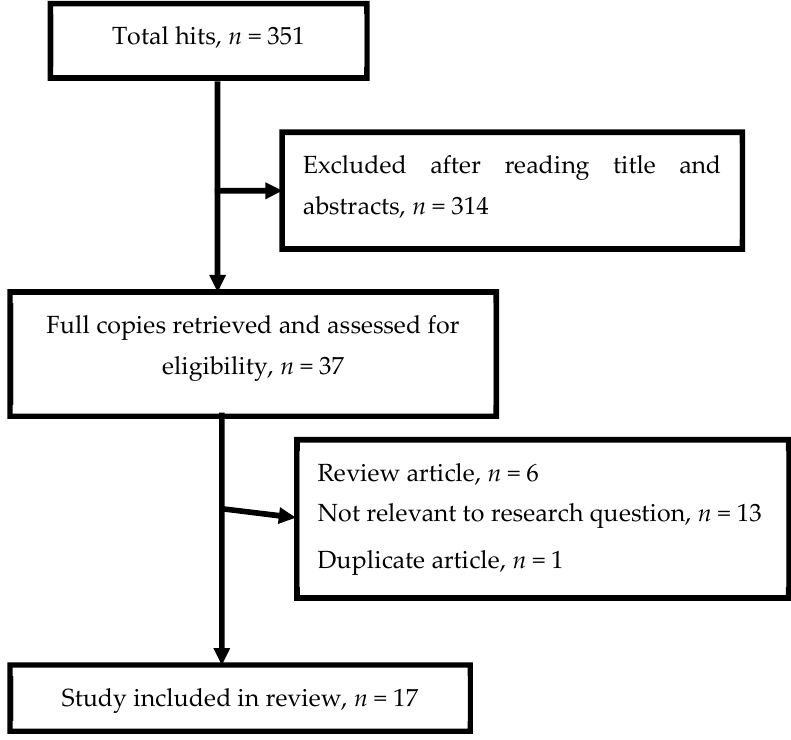
Figure 1. Flow chart of study selection process.